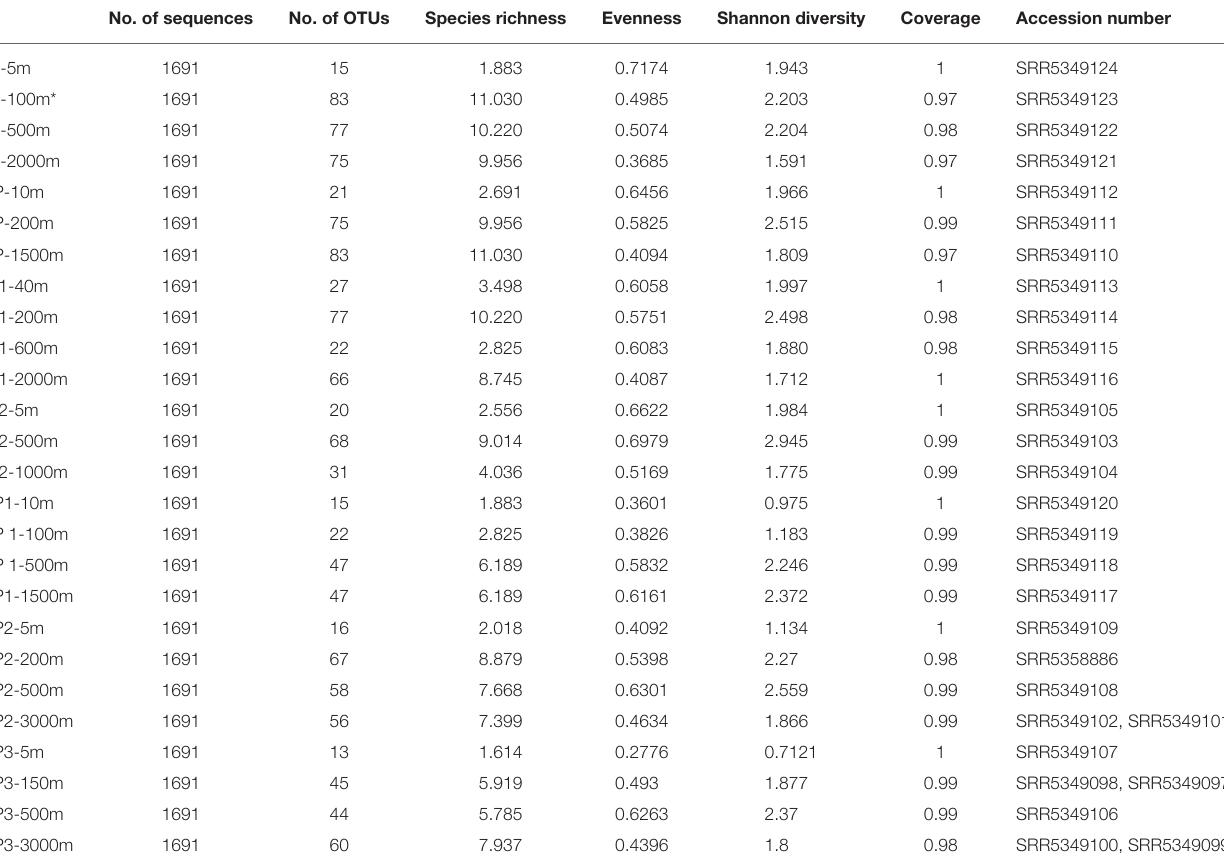
TABLE 2 | Diversity estimates for water samples collected from seven sites in the North Pacific Ocean obtained by 454 pyrosequencing. No. of sequences No. of OTUs Species richness Evenness Shannon diversity Coverage